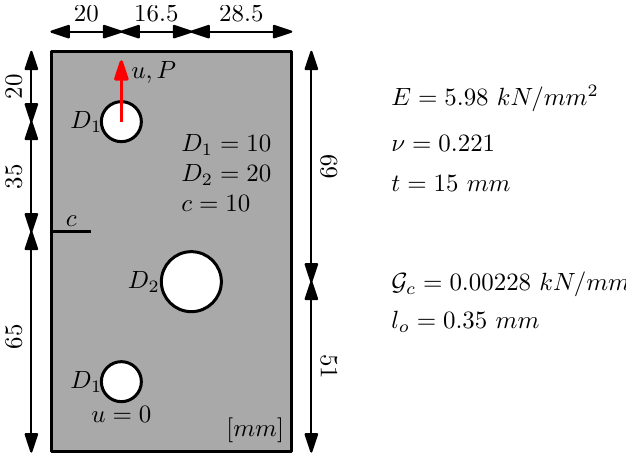
Figure 23. NPwH geometry, material parameters, loading and boundary